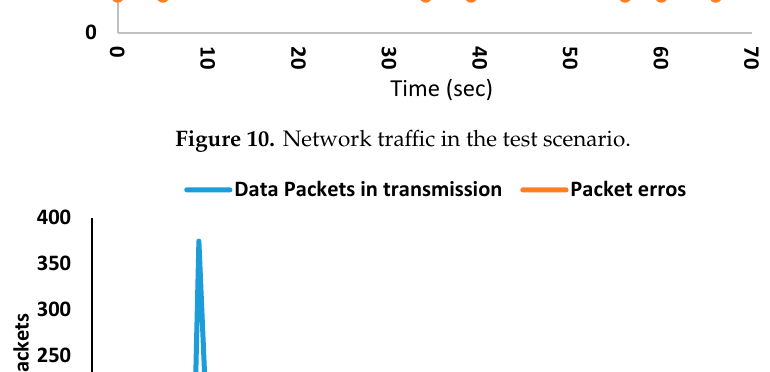
Figure 10. Network traffic in the test scenario.